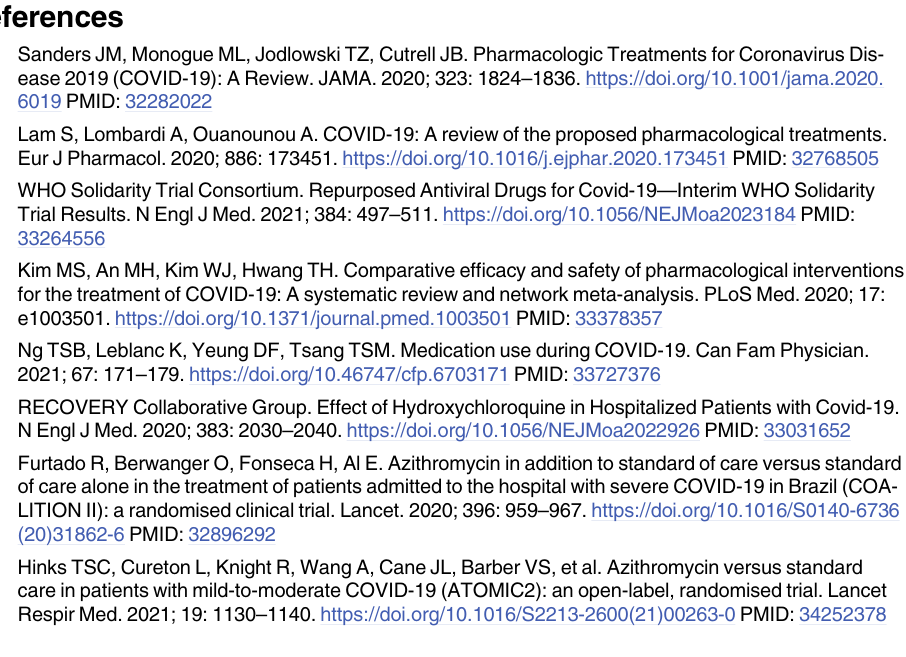
S2 Table. List of articles excluded after full-text